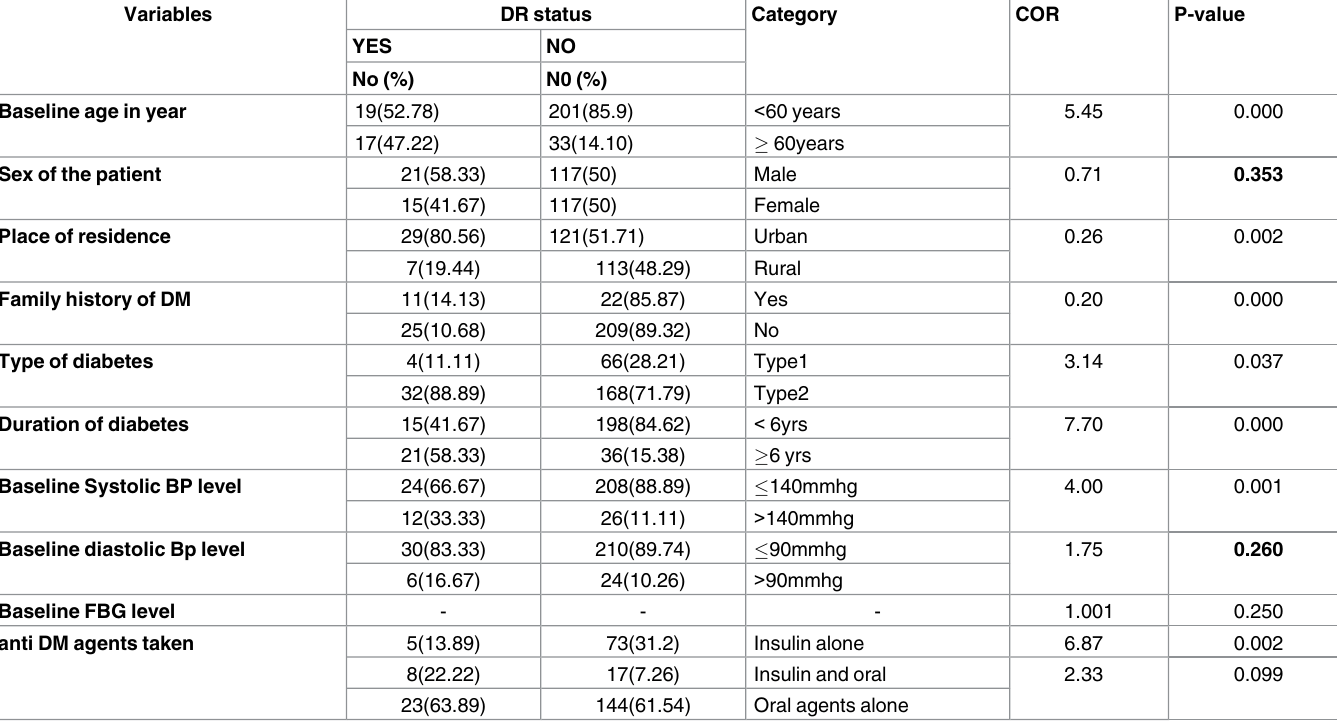
Table 2. Bi-variatelogistic regression analysis of diabetic patients at Arbaminch general hospital, 2015/16,(n =